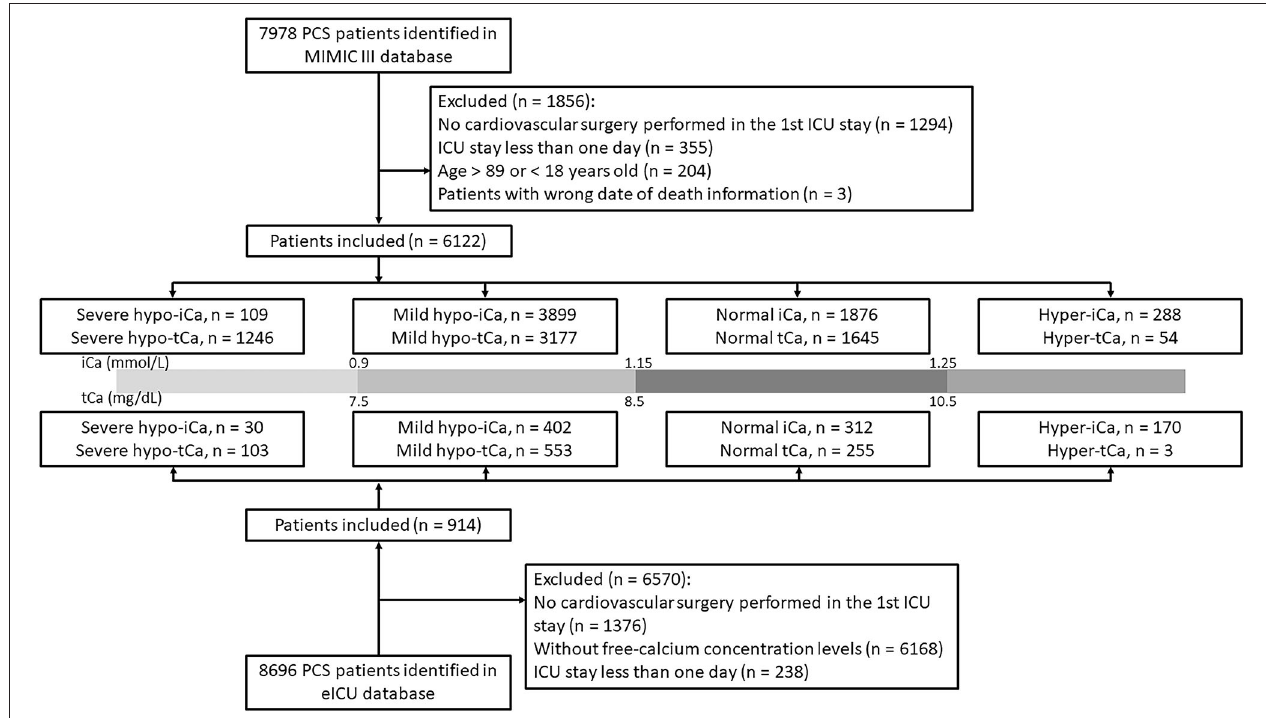
FIGURE 1 | Flow chart of patient selection in two